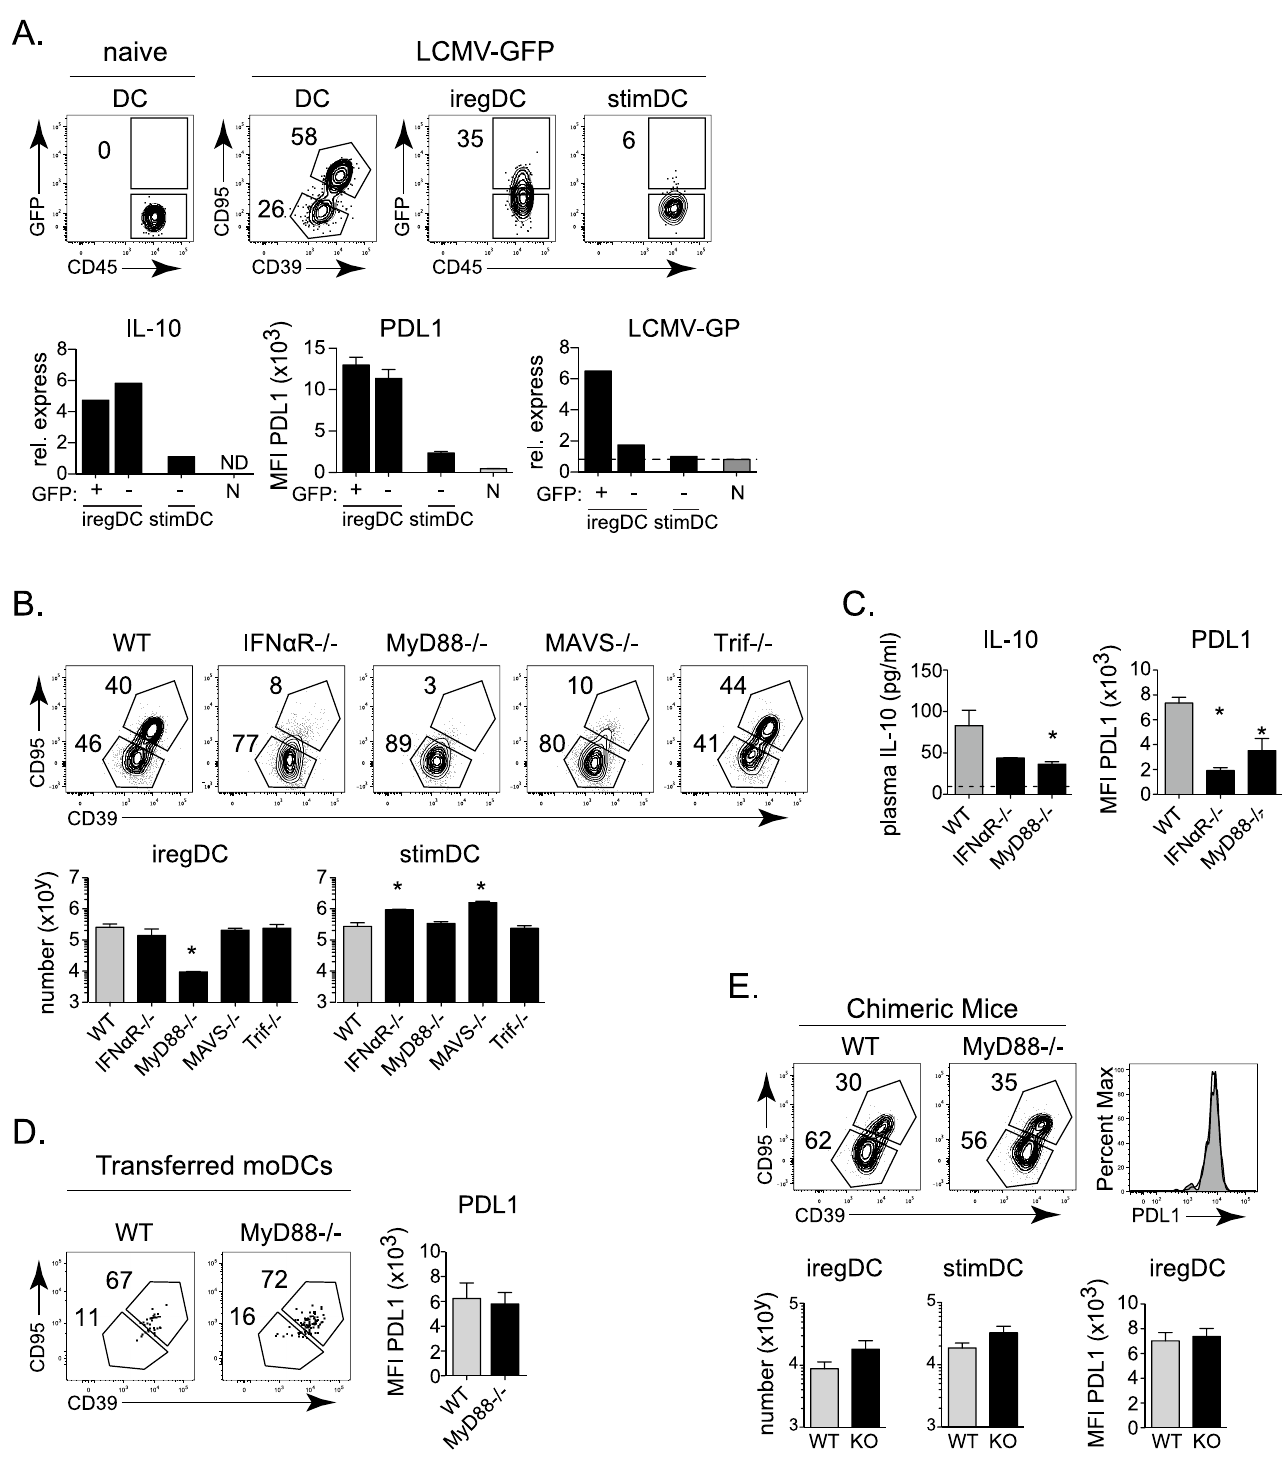
Fig 5. iregDC extrinsic MyD88 signaling, but not direct LCMV infection or IFN β signaling is required for iregDC differentiation. A. WT mice were CD8 depleted and then infected with LCMV-Cl13-GFP. Flow plots show GFP expression (i.e., LCMV infection) in splenic iregDC and stimDC (gated on CD39 and CD95) on day 9 after infection. In parallel, na ï ve splenic DC (N), and iregDC and stimDC were FACSorted based on GFP expression on day 9 after infection. The level of GFP+ stimDC was too small to obtain adequate numbers for RNA isolation. Bar graphs show relative expression of IL-10 RNA, LCMV-GP RNA and the MFI of PDL1 protein expression from the sorted populations. To obtain sufficient cell numbers for the RNA analyses, infected and